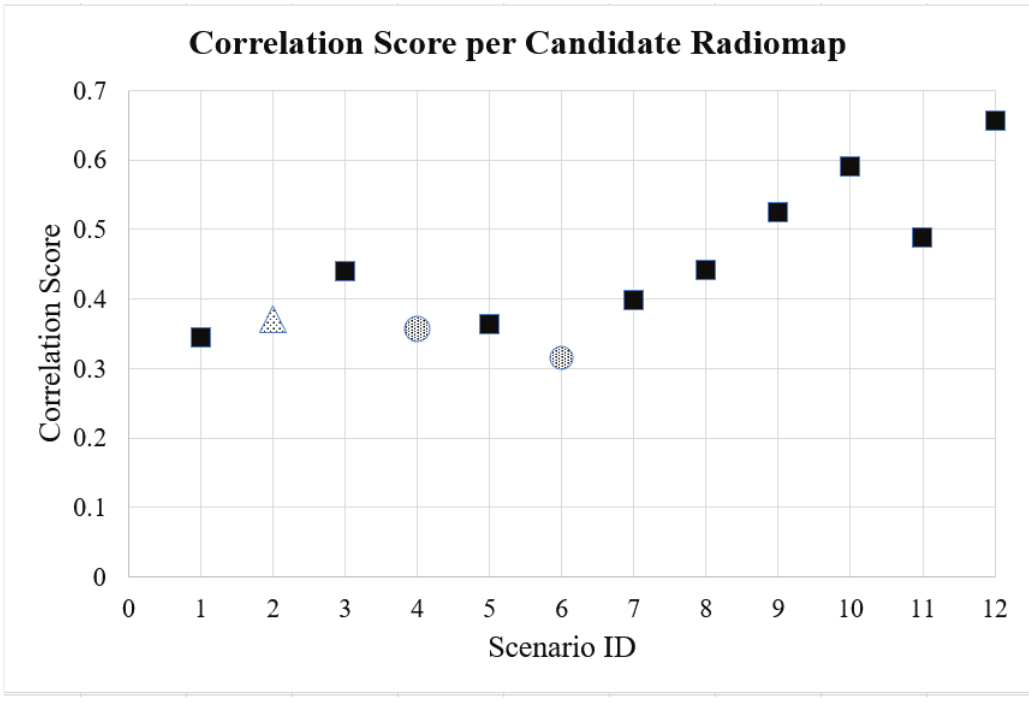
Figure 8. Correlation score per